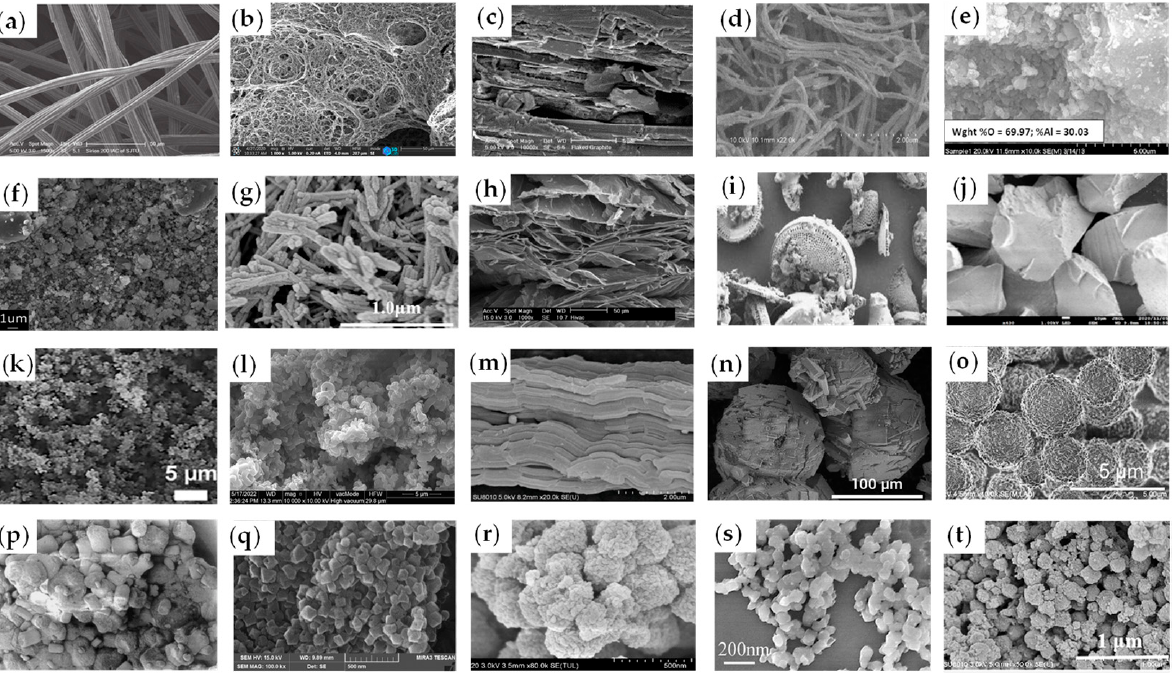
Figure 14. SEM images of activated carbon fiber felt ( a ) [98], activated carbon foam ( b ) [99], expanded natural graphite ( c ) [102], carbon nanotubes ( d ) [104], activated alumina ( e ) [107], zeolite 13X ( f ) [106], a tt apulgite ( g ) [113], expanded vermiculite ( h ) [114], diatomite ( i ) [115], silica gel ( j )